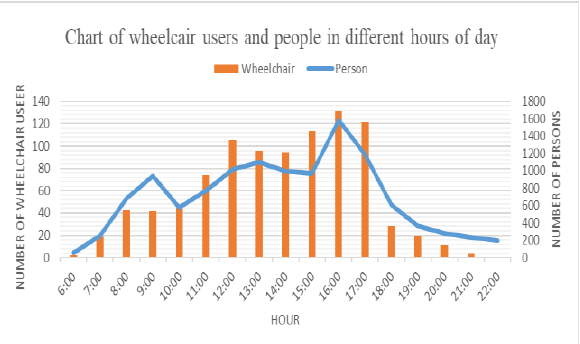
Chart 2. Number of wheelchair users and people in different hours of the